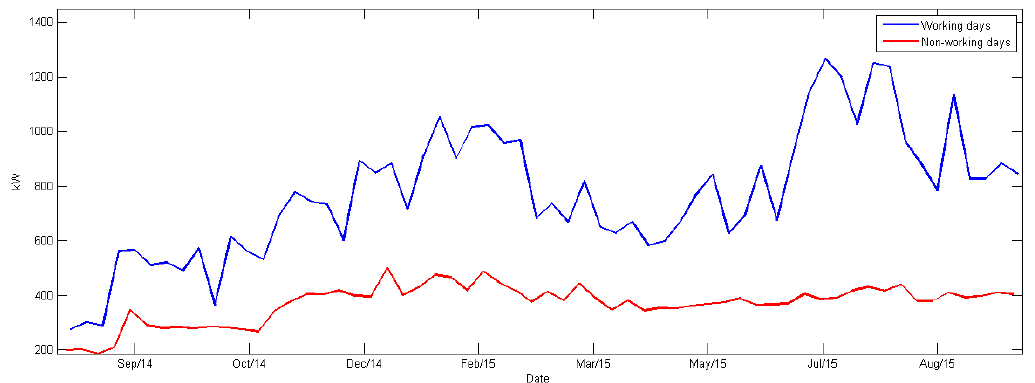
Figure 10. Example of a building average consumption with different behavior between working days and non-working days.